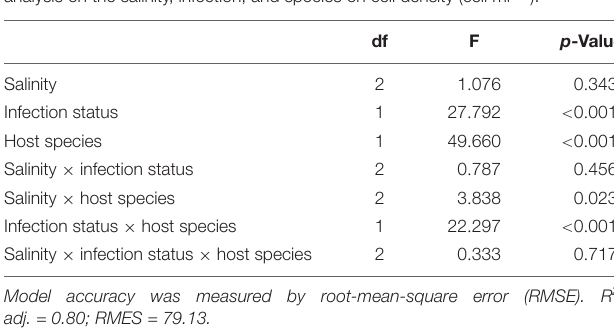
TABLE 2 | ANOVA style-results of the generalized additive mixed models (GAMM) analysis on the salinity, infection, and species on cell density (cell ml − 1 ).